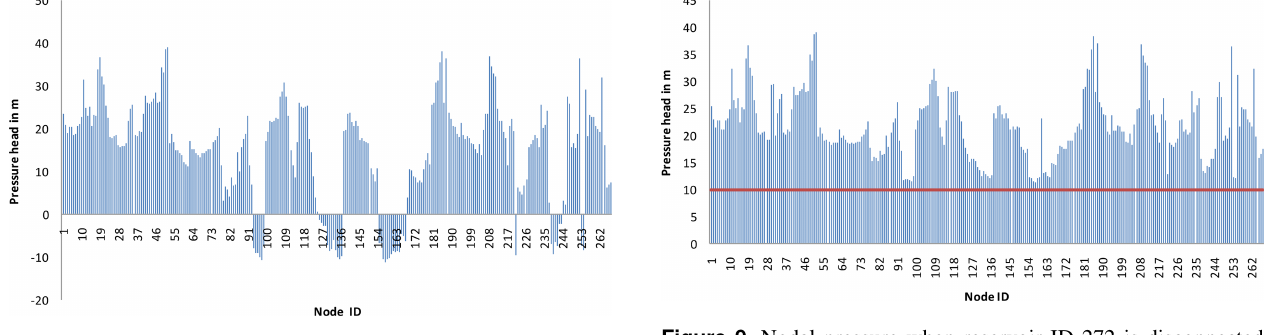
Figure 8. Nodal pressure when reservoir ID 272 is disconnected (DDA).